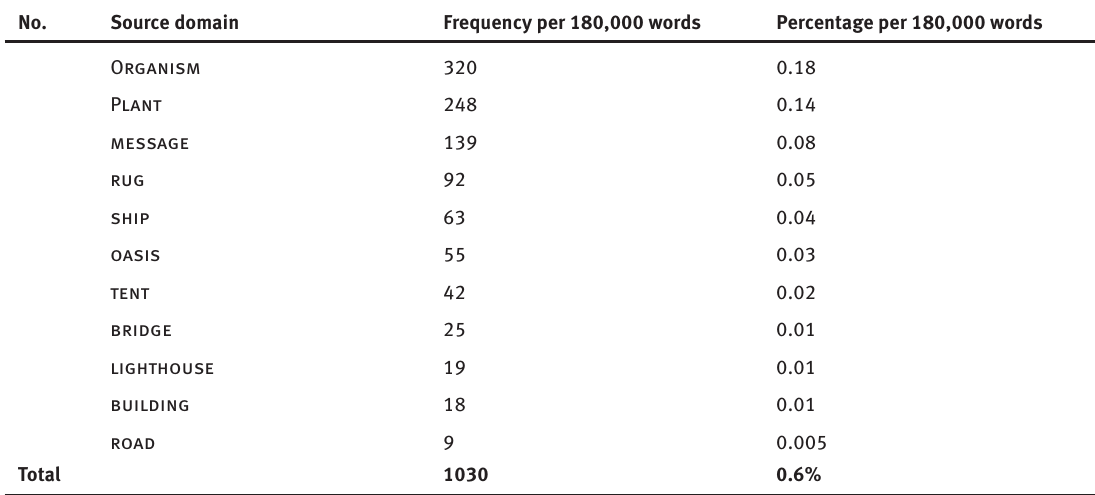
Table 1: Source domains used to conceptualise tolerance and the frequency and parentage of the metaphorical expressions representing them in the target newspapers